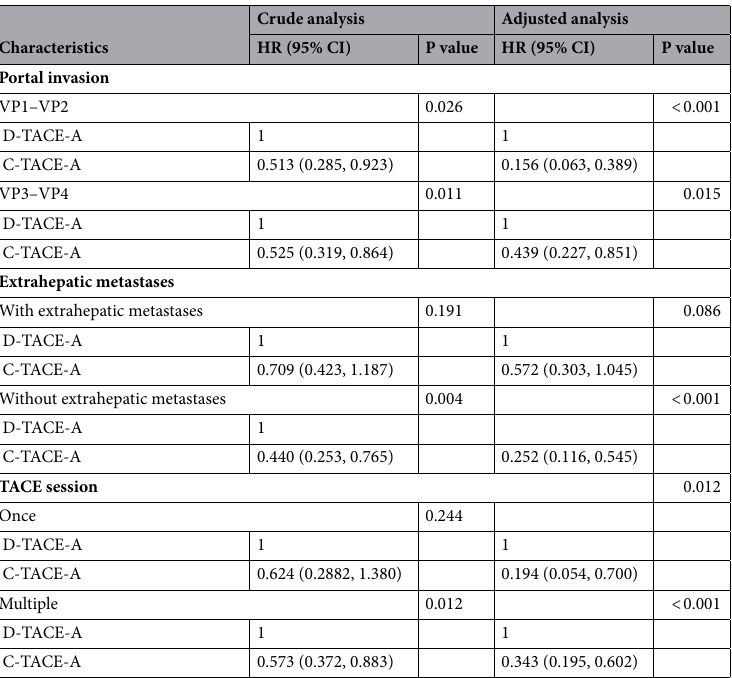
Table 5. Adjusted Cox proportional risk analysis of OS for subgroup analysis before PSM. Adjusted for age, ALT, leukocyte, lymphocytes, platelet, tumor size, gender, HBV infection, cirrhosis, TACE session, tumor number, AFP level, Child–Pugh, ECOG.